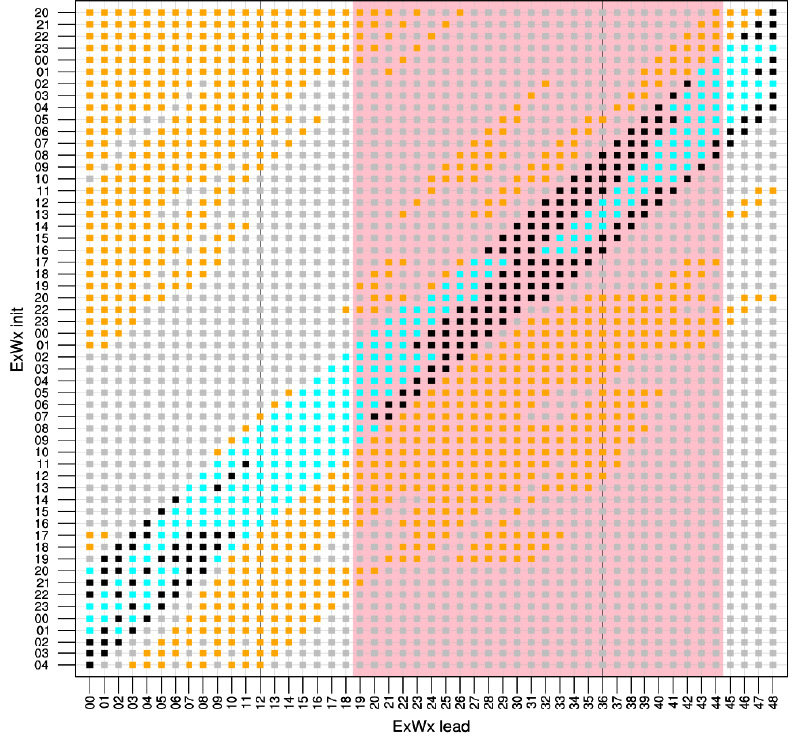
Figure 11. Forecasts of icing potential, combined from all turbines on a single farm, from 57 consecutive runs of the extreme weather system (y-axis). The first run shown is the 2000 UTC forecast from the extreme weather system on 24 December, 2014. Black shading indicates valid times within the event window (2000 UTC on 25 December–0400 UTC on 26 December) with an icing potential forecast of < 0.5, light blue shading indicates an icing potential forecast of > 0.5 within the event window, orange shading indicates an icing potential forecast of > 0.5 outside the event window, and gray shading indicates an icing potential forecast of < 0.5 outside the event window. Vertical lines indicate the division between C1, C2, and C3 DICast forecast system data (see Figure 9).